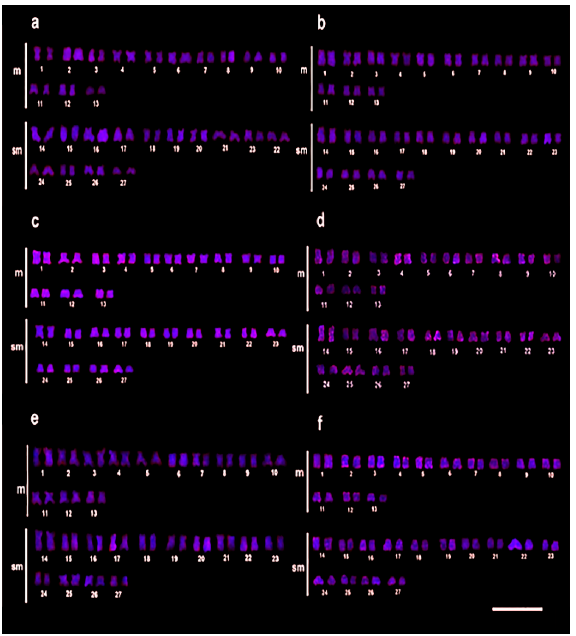
Figure 3. Chromosomal mapping of the Rex1 by FISH in C. macropomum. ( a ) FISH in the control group (C0 = 0.0 mg/L of Trichlorfon). ( b ) 30% LC 50–96 h -48 h of Trichlorfon (C1 = 0.261 mg/L). Even at higher concentrations, ( c ) 30% LC 50–96 h -72 h, ( d ) 50% LC 50–96 h -48 h (C2 = 0.435 mg/L of